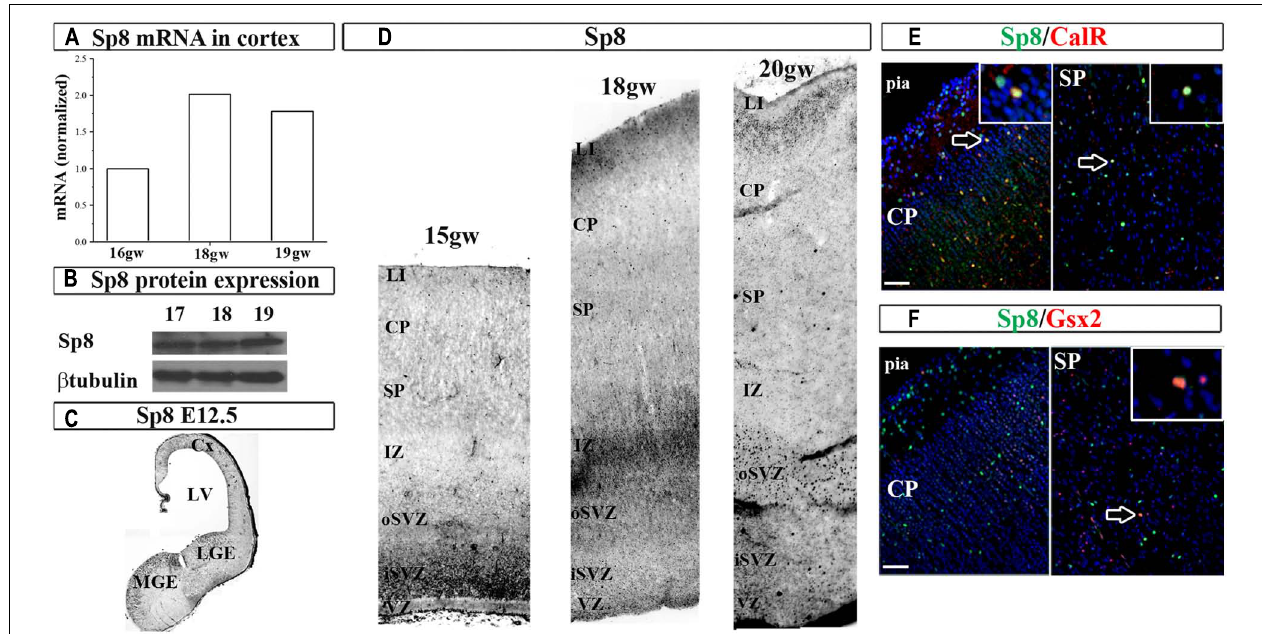
and (F) Gsx2 (red) in cortical plate and subplate. VZ, ventricular zone; iSVZ, inner subventricular zone; oSVZ, outer subventricular zone; IZ, intermediate zone; SP, subplate; CP, cortical plate; Cx, cortex; LV, lateral ventricle; CGE, caudal ganglionic eminence; MGE, medial ganglionic eminence. Scale bar, 50 μ